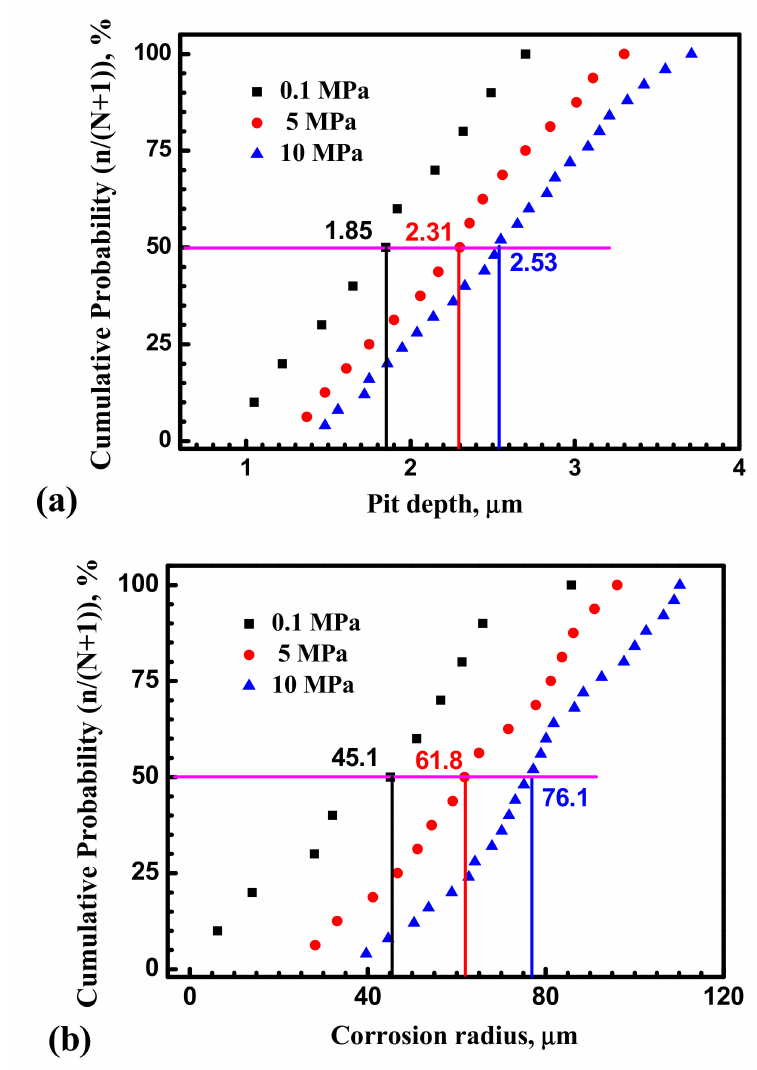
Figure 12. The 3D sizes of corrosion pits of the X70 steel at 0.1 MPa, 5 MPa and 10 MPa after 30 min immersion in 0.1 mol/L NaCl solution: ( a ) Pit depth; ( b ) Corrosion